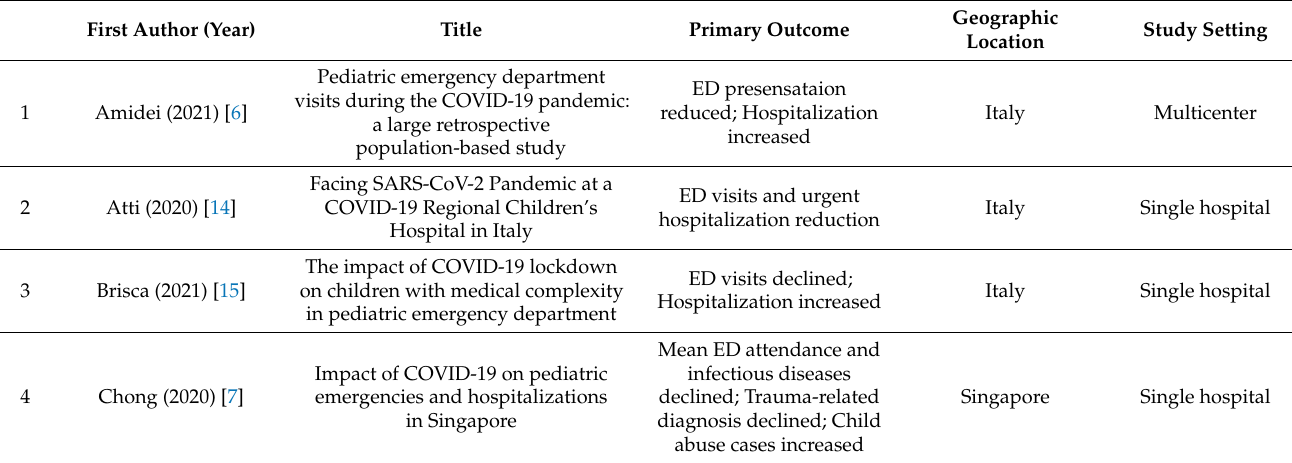
Table 1. Key information of the included original articles.